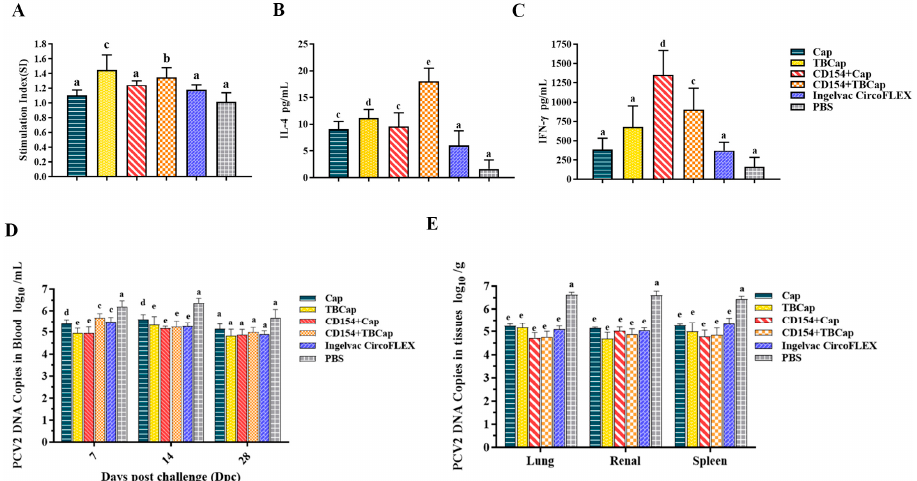
Figure 8. Cytokine secretion and viral load. ( A ) The stimulation of splenic lymphocyte samples collected at 42 dpi. ( B ) Quantitative analysis of interleukin 4 (IL-4) in the supernatant of PCV2-stimulated splenic lymphocytes in immunized mice at 42 dpi. ( C ) Quantification of interferon-gamma (IFN- γ ) in the supernatant of PCV2-stimulated splenic lymphocytes in immunized mice at 42 dpi. ( D ) PCV2 DNA loads (copies/mL) in blood collected at 7, 14 and 28 DPC. ( E ) PCV2 DNA loads (copies/g) in tissues collected on the day of necropsy. Different superscripts (a, b, c, d, e) indicate statistically significant differences in lymph node viral load between the test groups ( p < 0.05).